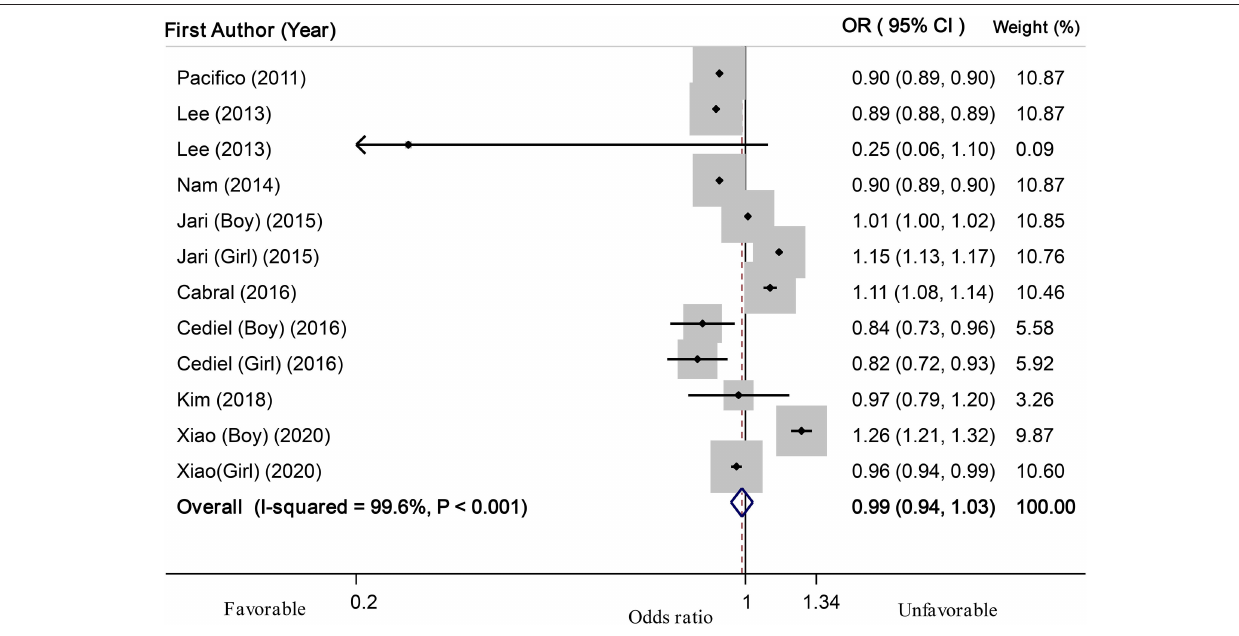
FIGURE 3 | Linear dose-response meta-analysis of the relationship between each 10ng/ml (25 nmol/L) increment in serum 25(OH) D levels and abdominal obesity in children and adolescents.